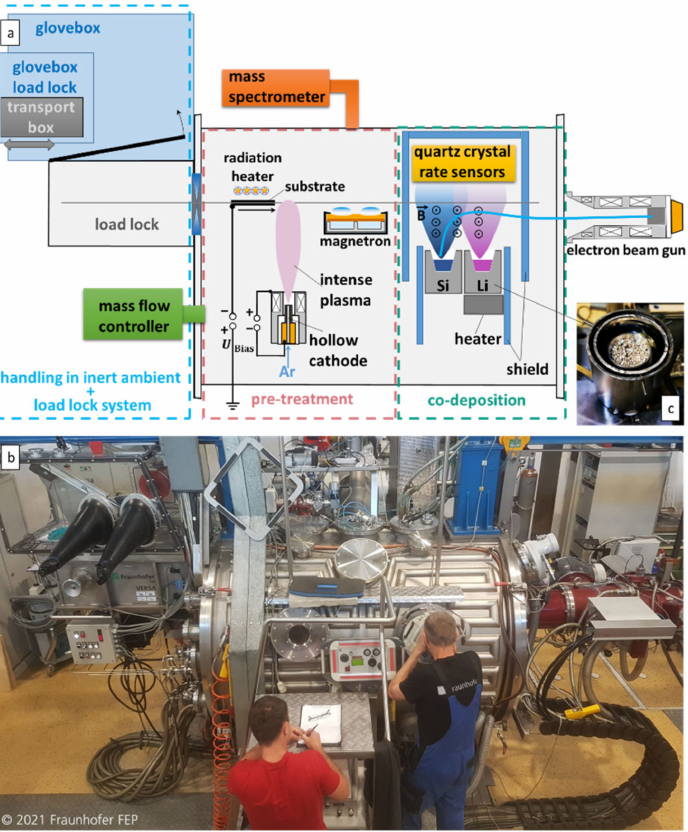
Figure 2. Schematic of the experimental setup used for PVD of lithium and silicon ( a ); picture of the prepared high-vacuum tool, VERSA ( b ); crucible filled with lithium granulate as evaporation feedstock ( c